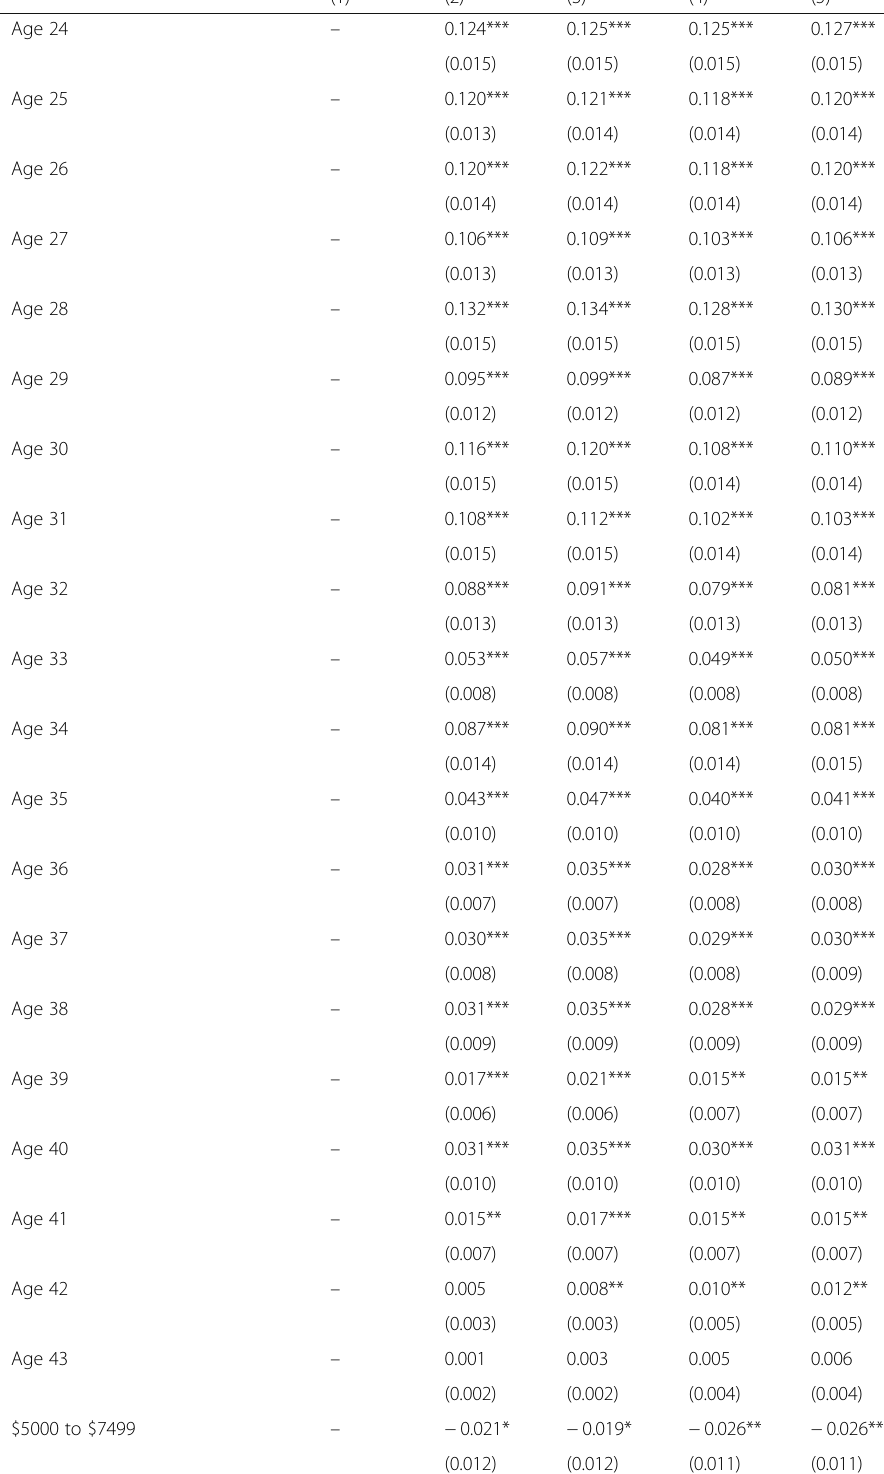
Table 6 Full set of coefficient estimates for Table 4 regressions